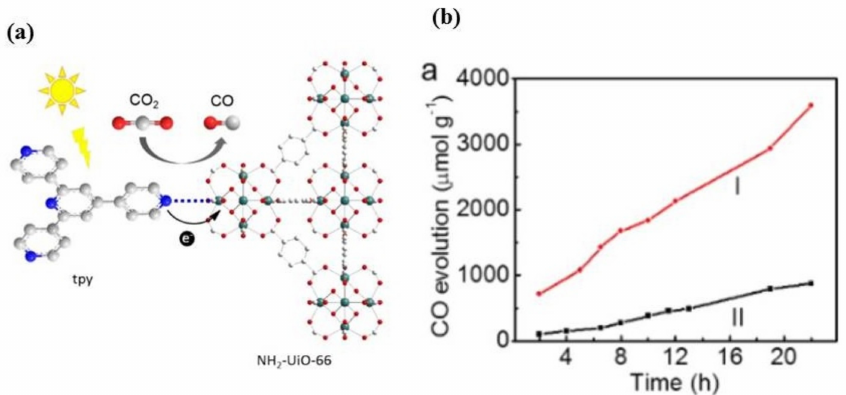
Figure 18. Reaction pathways over NH 2 -MOFs (Fe) [226].